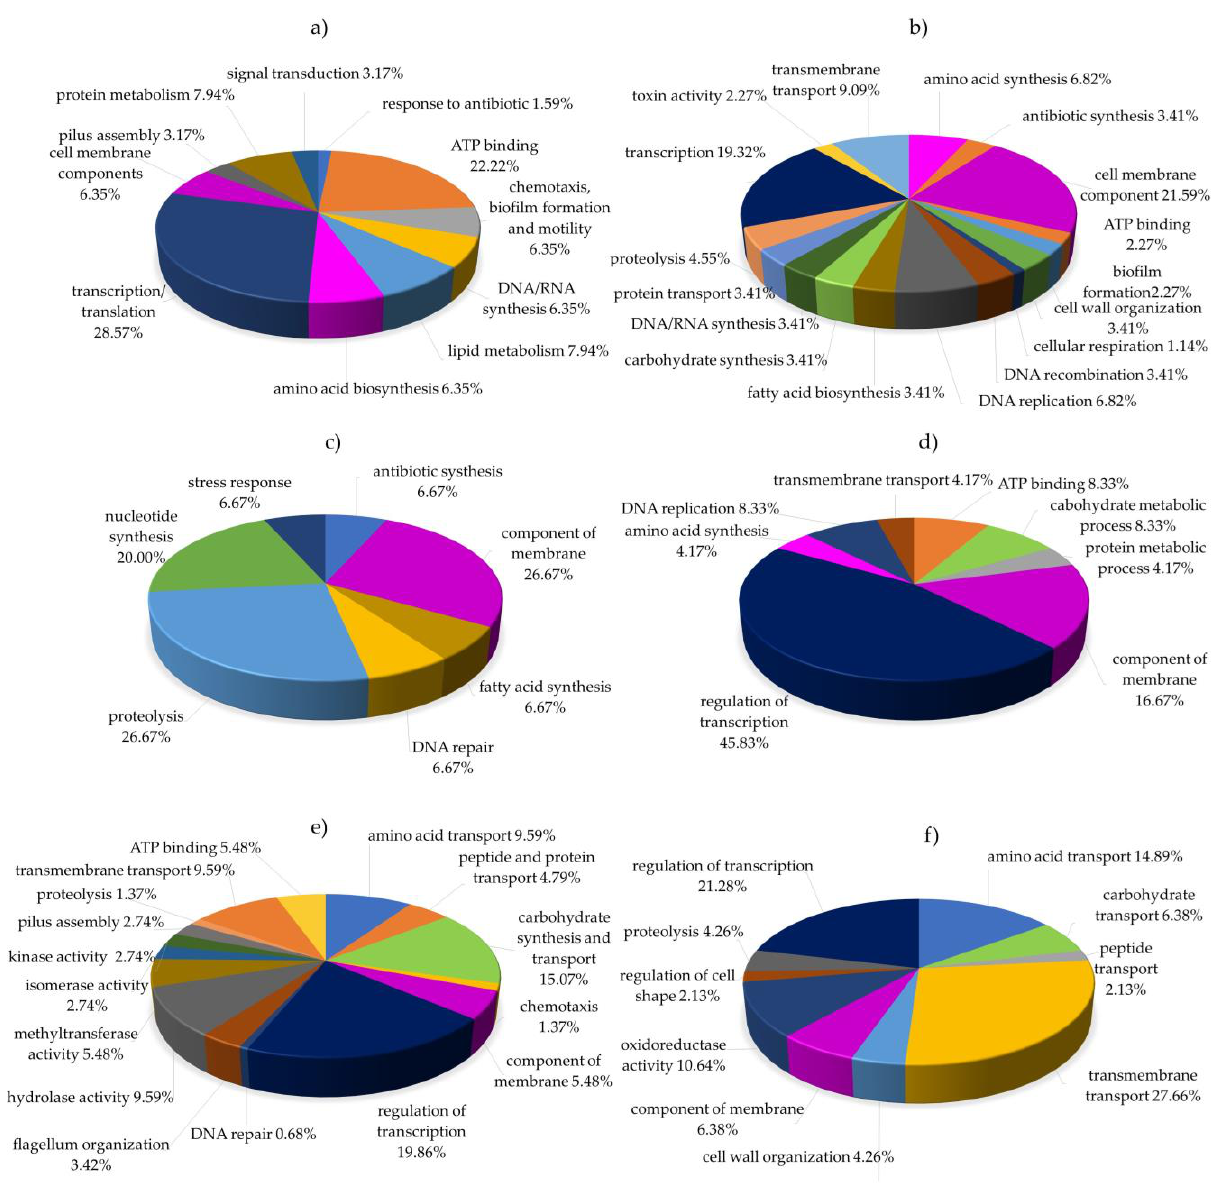
Figure 3. Functional classification distributions of differentially expressed proteins in peptide-treated human pathogens: ( a ) P. aeruginosa treated with peptide no.3, ( b ) P. aeruginosa treated with peptide no.4, ( c ) Bacillus subtilis treated with peptide no.3, ( d ) Bacillus subtilis treated with peptide no.4, ( e ) Burkholderia cepacia treated with peptide no.3, and ( f ) Burkholderia cepacia treated with peptide no.4.